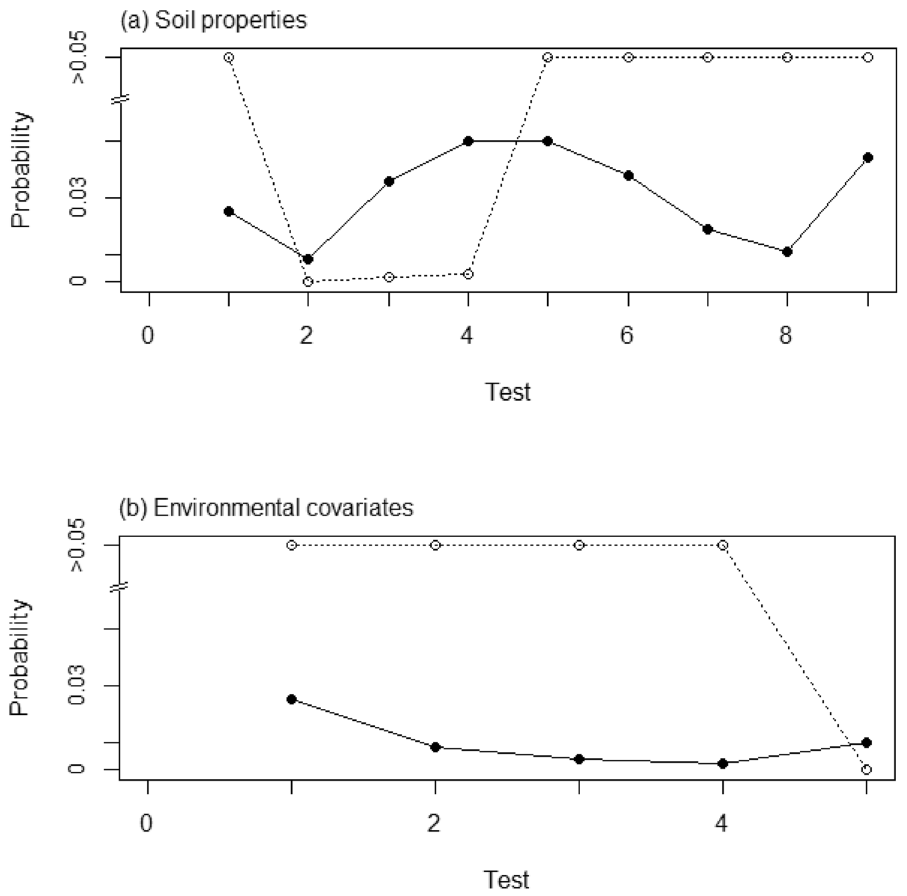
Figure 1. The p -values (open circles) for successive tests on predictors added to the model for grain Zn from ( a ) soil properties and ( b ) environmental covariates. Tests are on addition of variables in the order given in Table 1. The solid circles are the threshold for rejection of each null hypothesis under the FDR